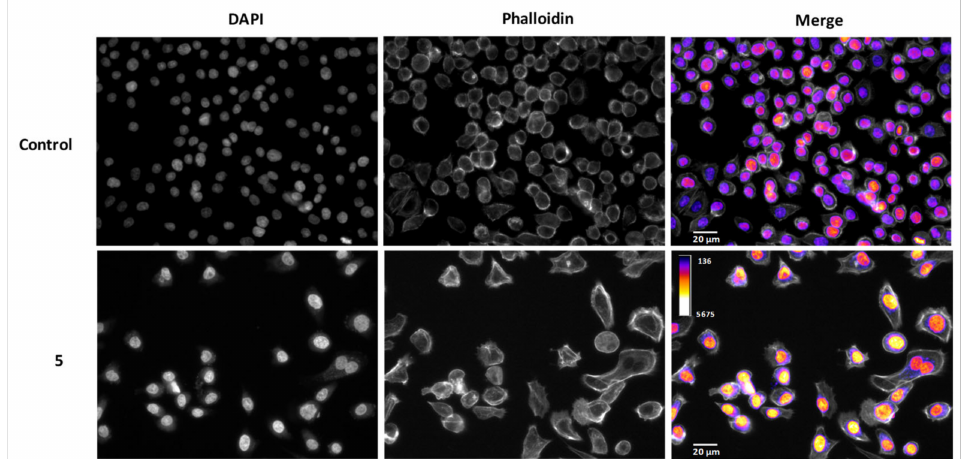
Figure 3. Morphological assessment of AGS cells incubated with compound 5 (100 µ M, 24 h). DNA was studied using DAPI and overall cell morphology with